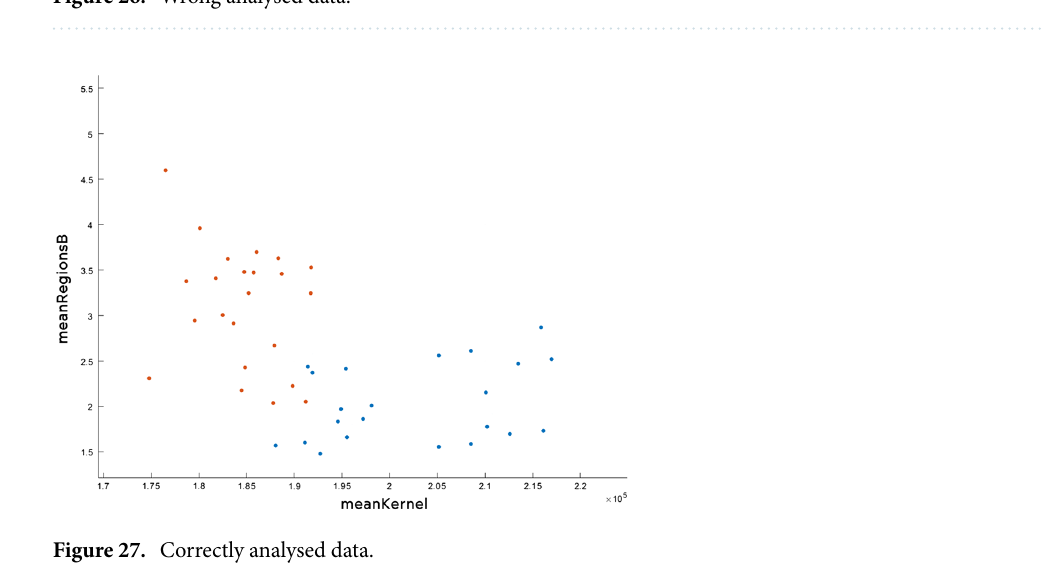
Figure 26. Wrong analysed data.